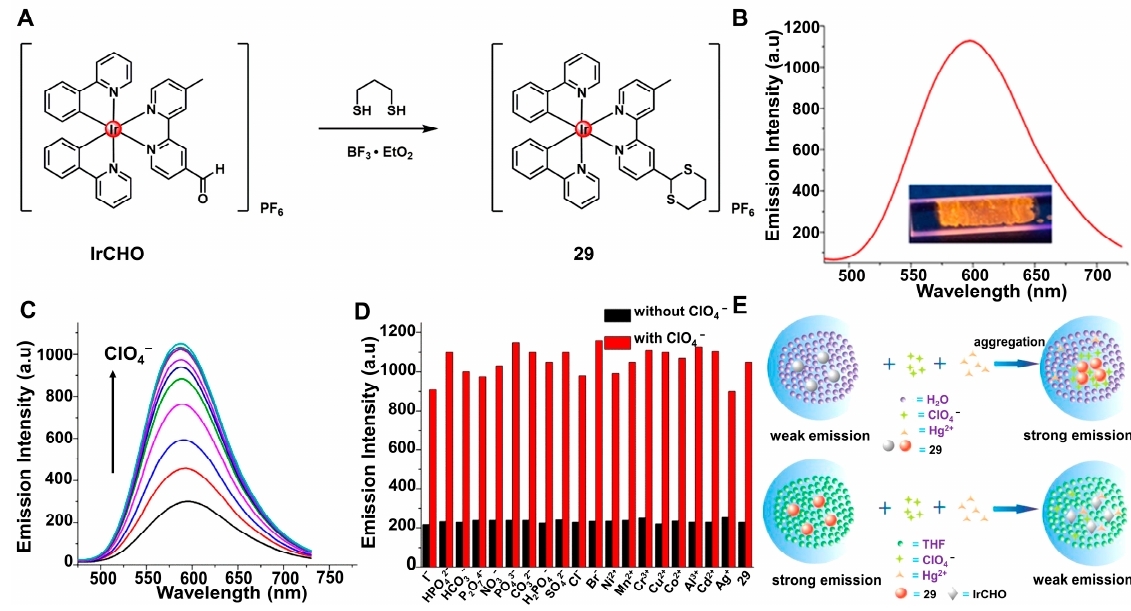
Figure 12. ( A ) Synthetic route of 29 . ( B ) The emission spectrum of 29 in solid state. Inset: emission image of 29 in solid state under 365 nm UV illumination. ( C ) Emission spectrum of 29 upon addition of NaClO 4 − in HEPES buffer solution, λ ex = 388 nm. ( D ) PL spectrum of 29 towards other ions in HEPES buffer solution at room temperature. ( E ) The mechanics of 29 in presence of Hg(ClO 4 ) 2 in THF and in H 2 O. Reprinted with permission from [75], copyright 2016, Elsevier.